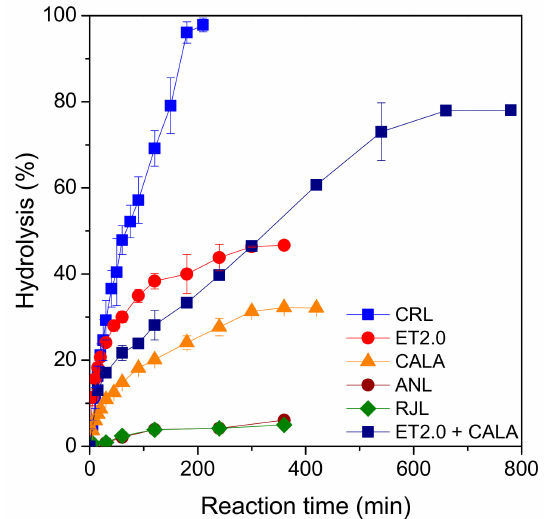
Figure 1. Influence of reaction time on the hydrolysis percentage of USCO catalyzed by microbial lipases with different specificities: CRL ( Candida rugosa ), ET2.0 ( Thermomyces lanuginosus ), CALA ( Candida sp.), ANL ( Aspergillus niger ), RJL ( Rhizopus javanicus ) and a mixture ET2.0 + CALA. The reactions were conducted in the absence of emulsifier and buffer agents using an oil:water mass ratio of 40%, continuous mechanical stirring (1500 rpm), 40 ◦ C and initial lipase loading of 50 U per gram of reaction mixture. The units of hydrolytic activity used for the combination of specific lipases were 17 U of CALA + 33 U of ET2.0 per gram of reaction